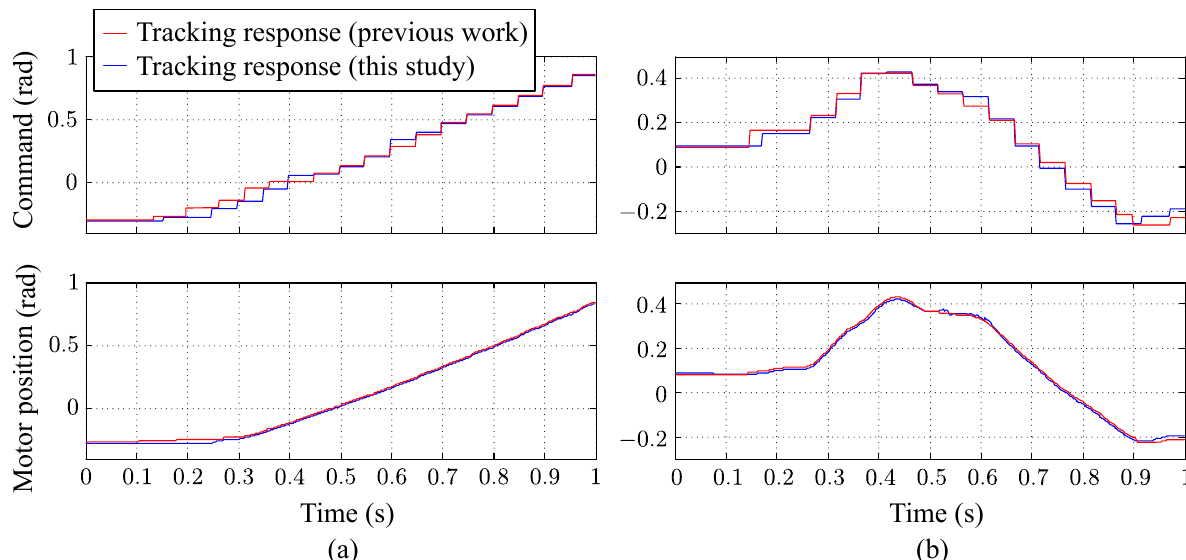
Figure 21. A flying ball: tracking response of ( a ) the pan-axis motor and ( b ) the tilt-axis